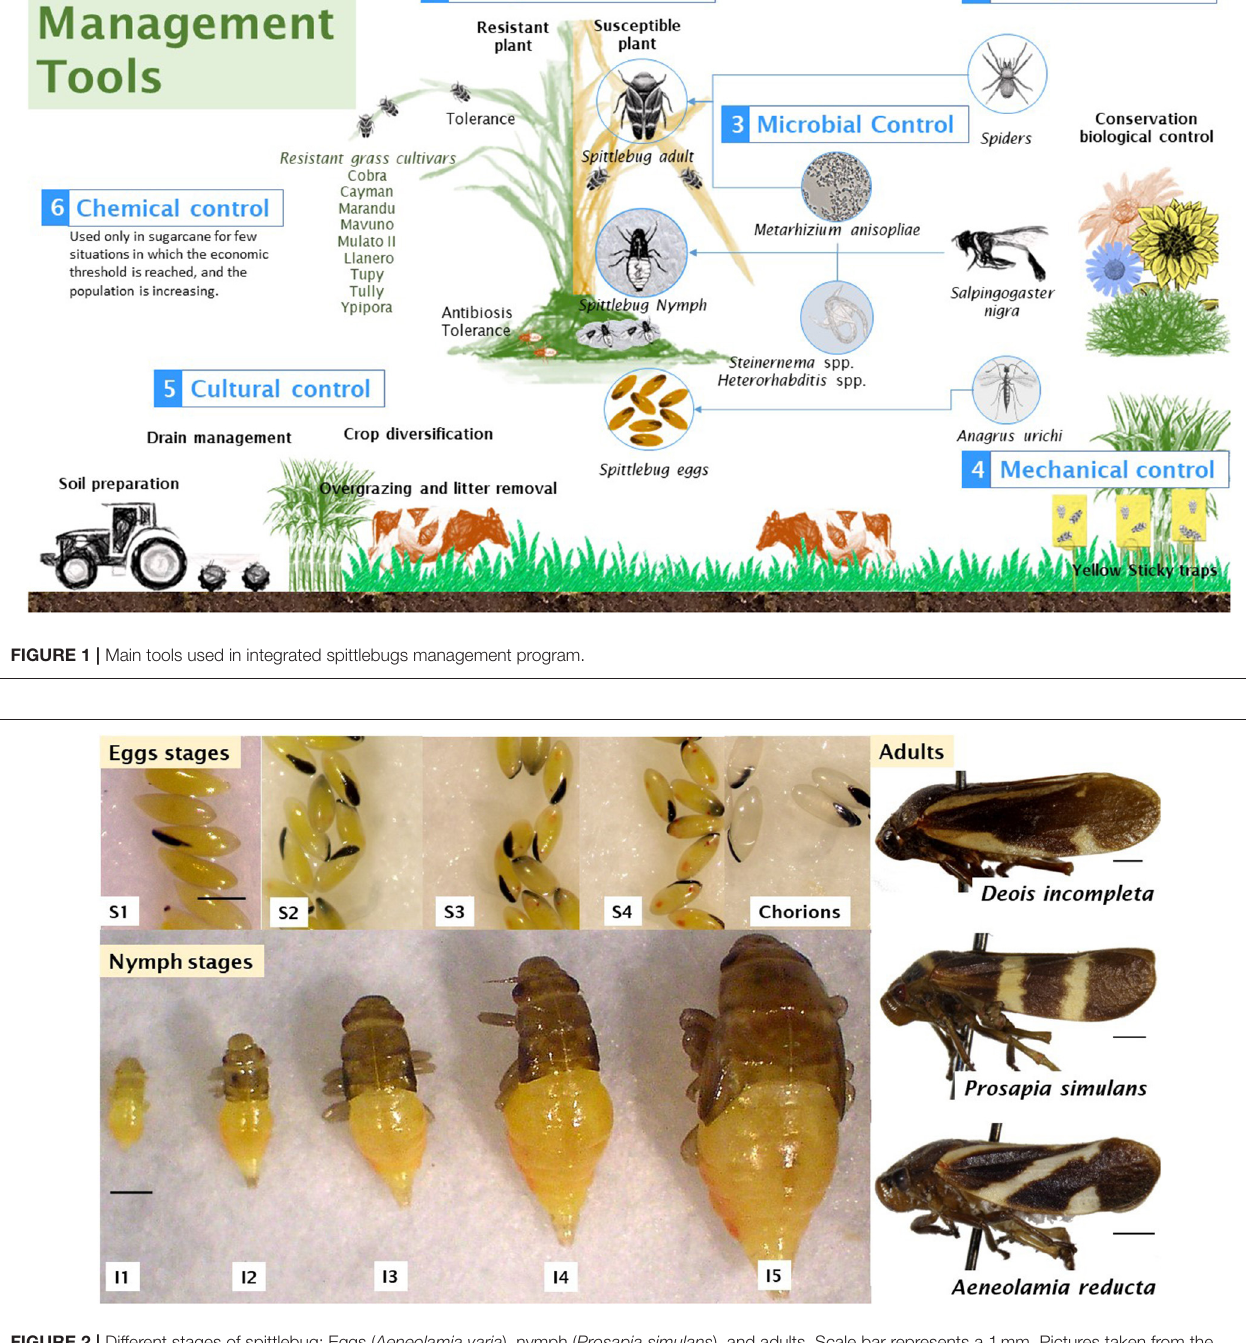
arginine, and phenyalanine, Zinderia presented those for tryptophan, methionine, and histidine (McCutcheon and Moran, 2010). Foieri et al. (2022) reported Candidatus sulcia muelleri in